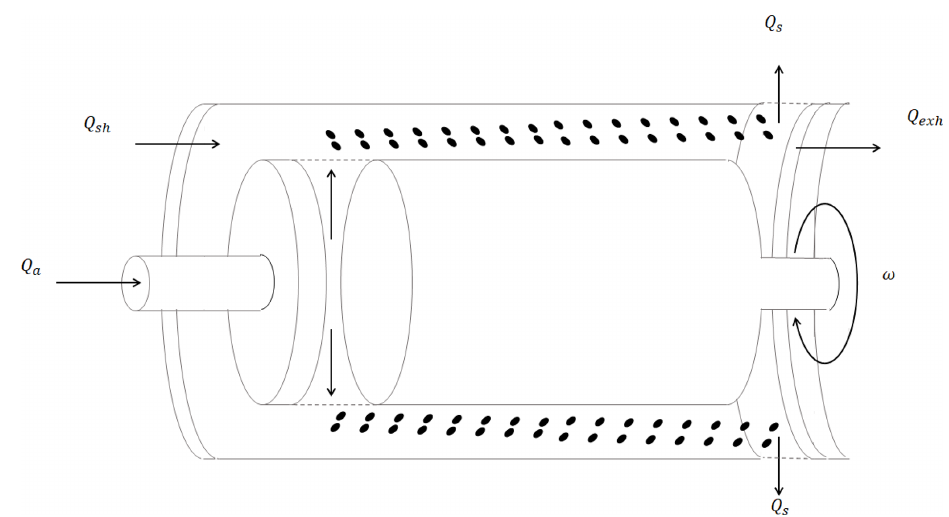
Figure 1. The schematic of how the aerodynamic aerosol classifier (AAC) size-selects particles. The rotating two-cylinder arrangement of the AAC subjects particles to a centrifugal force that is balanced by the drag force along the axial direction.